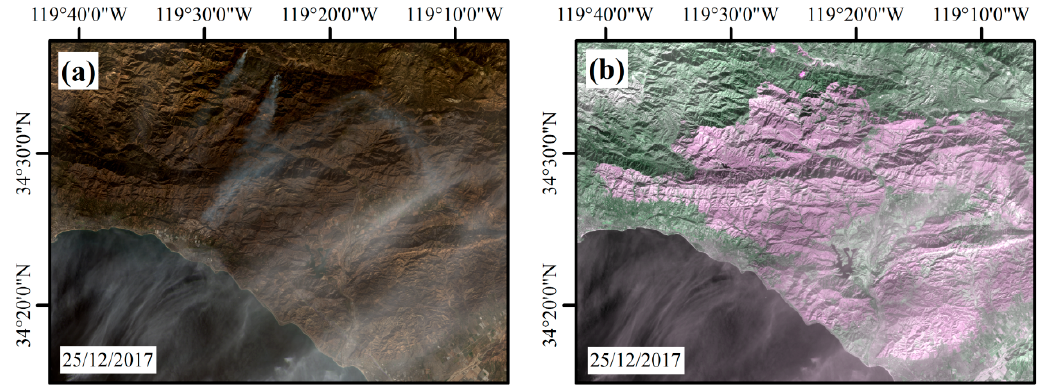
Figure 3. Fire analysis using Shortwave Infrared (SWIR). ( a ) True color image; ( b ) false color image (R = SWIR2, G = SWIR1, and B = SWIR2).